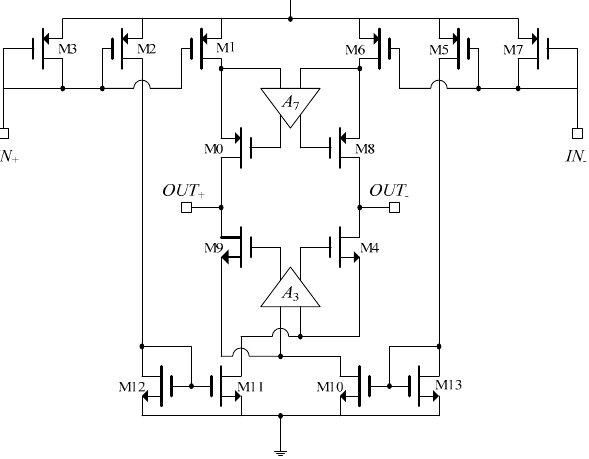
Figure 1. Integrated current driver in H-bridge configuration [5].